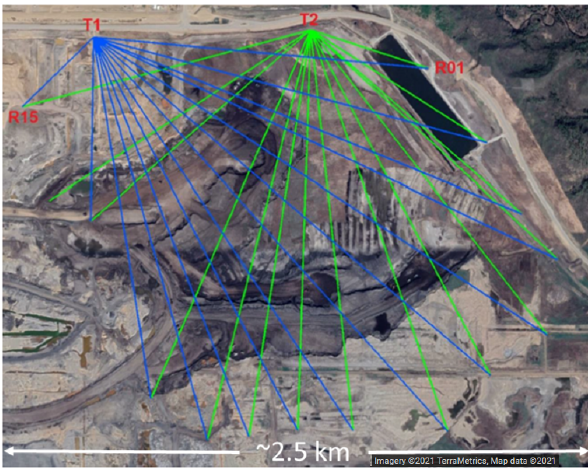
Figure 2. GreenLITE ™ system configuration at mine